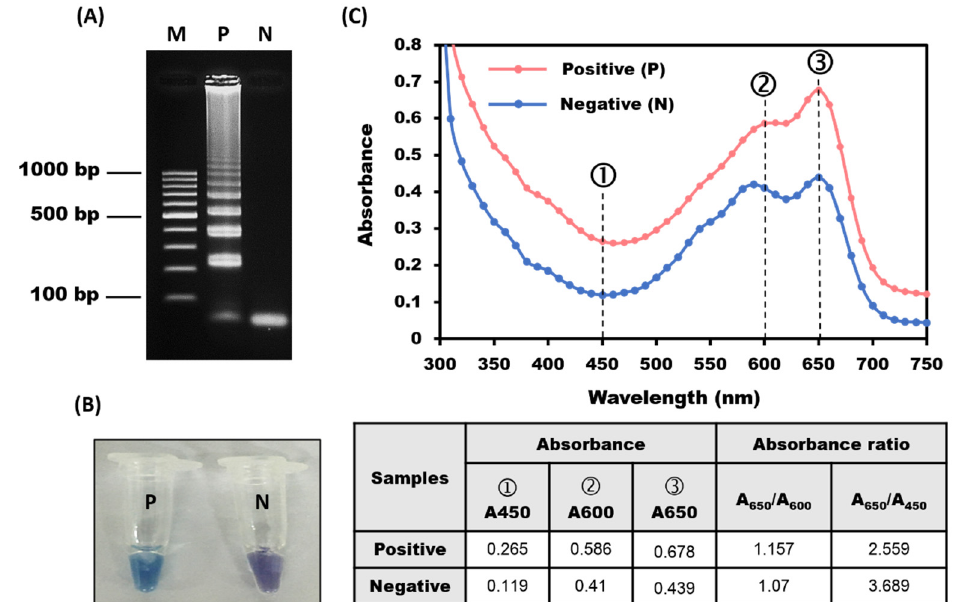
Figure 3. ( A ) LAMP profiles on 2% agarose gel electrophoresis. ( B ) Direct visualization under natural light and ( C ) spectra of LAMP with 0.12 mM hydroxy naphthol blue reaction. M, GeneRuler™ 100 bp DNA ladder marker (Thermo Scientific, USA); P, positive control; N, negative control (without DNA template).